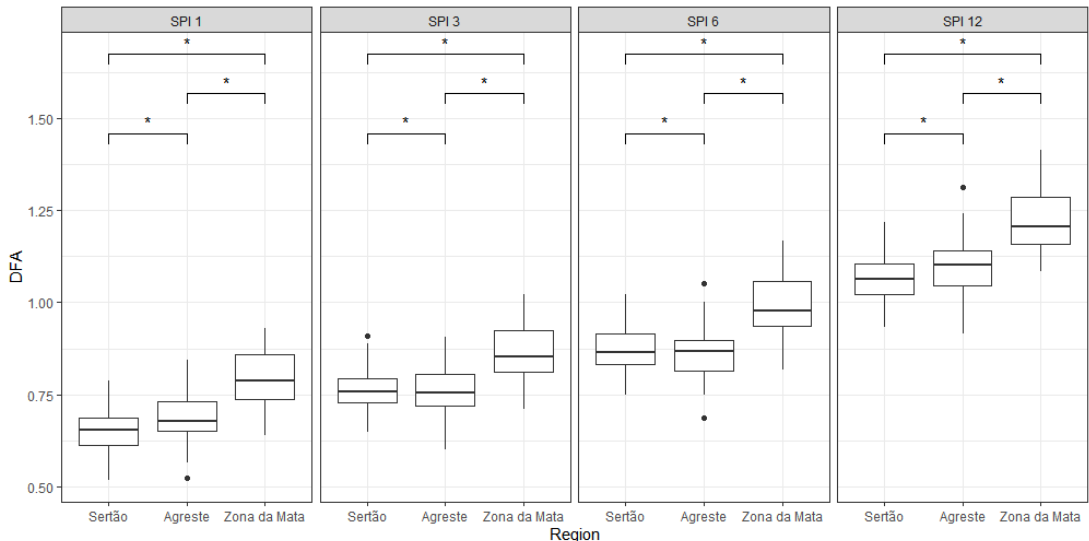
Figure 9. DFA exponents 𝛼 boxplots for each region for SPI at different time scales (SPI-1, SPI-3, SPI-6 and SPI-12). The star symbol “*” indicates that there is a significant difference between the regions at the 5% significance level ( 𝑝𝑣 < 0,05 )